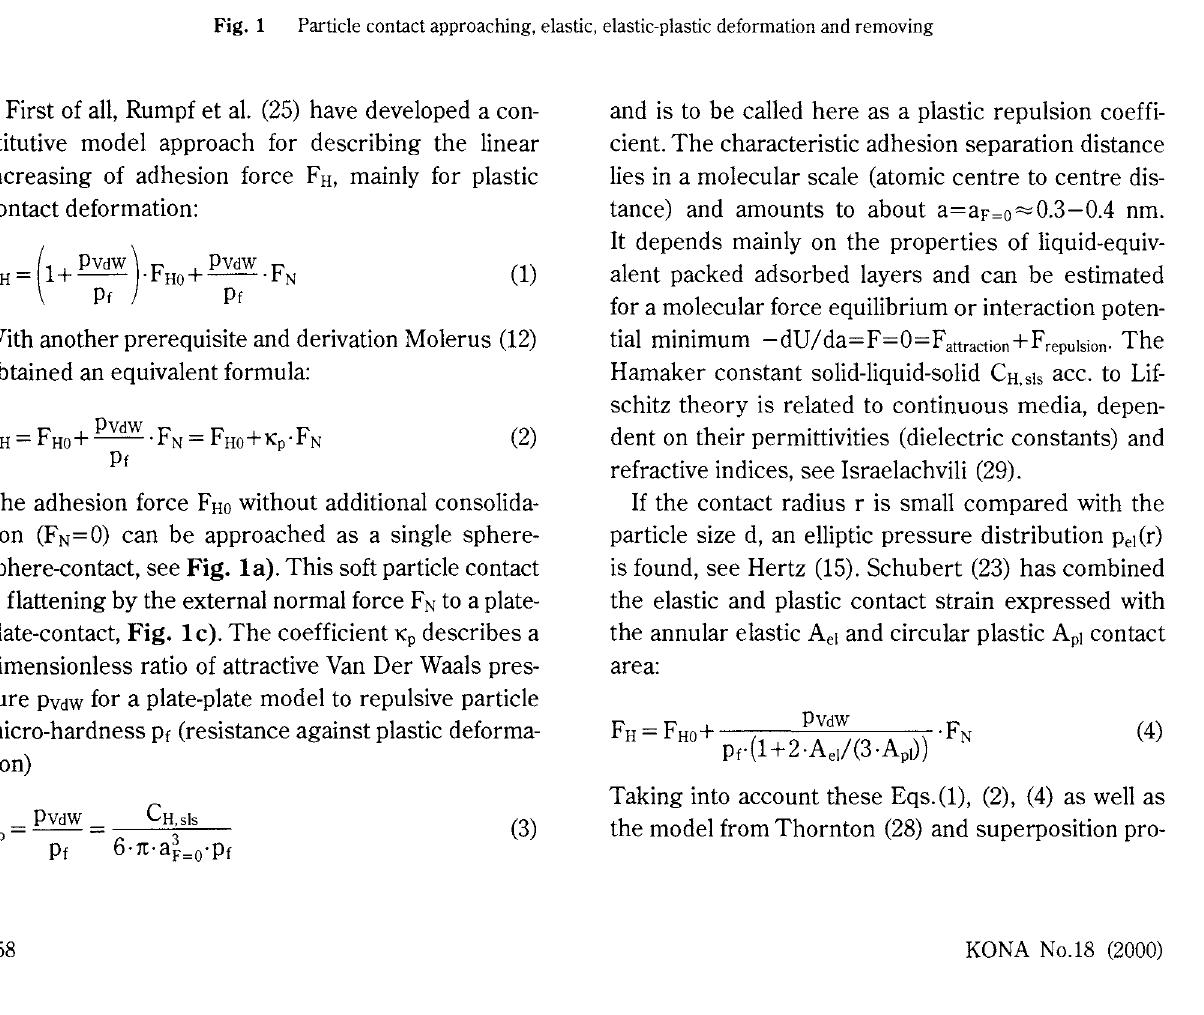
Particle contact approaching, elastic, elastic-plastic deformation and